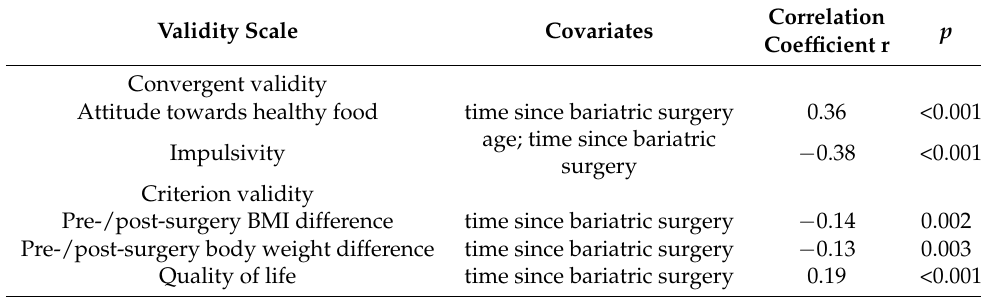
Table 5. Partial Pearson correlation analyses of the DBI-S score.